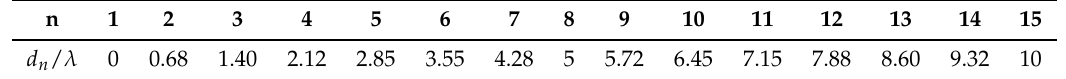
Table 6. Locations for the non-reweighted off-broadside design example, θ M = 10 ◦ . n